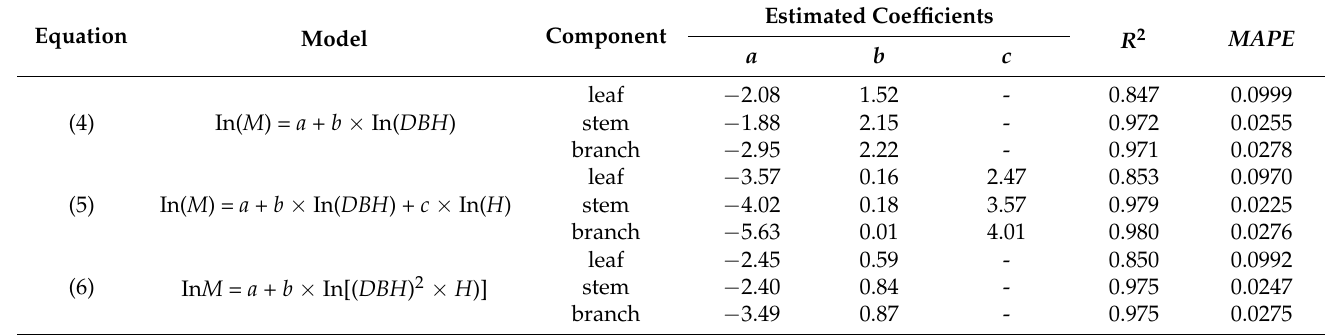
Table 2. Equation parameters ( a , b and c ) and evaluation statistics ( R 2 and MAPE ) of allometric models for predicting individual components of T . Zhongshanshan